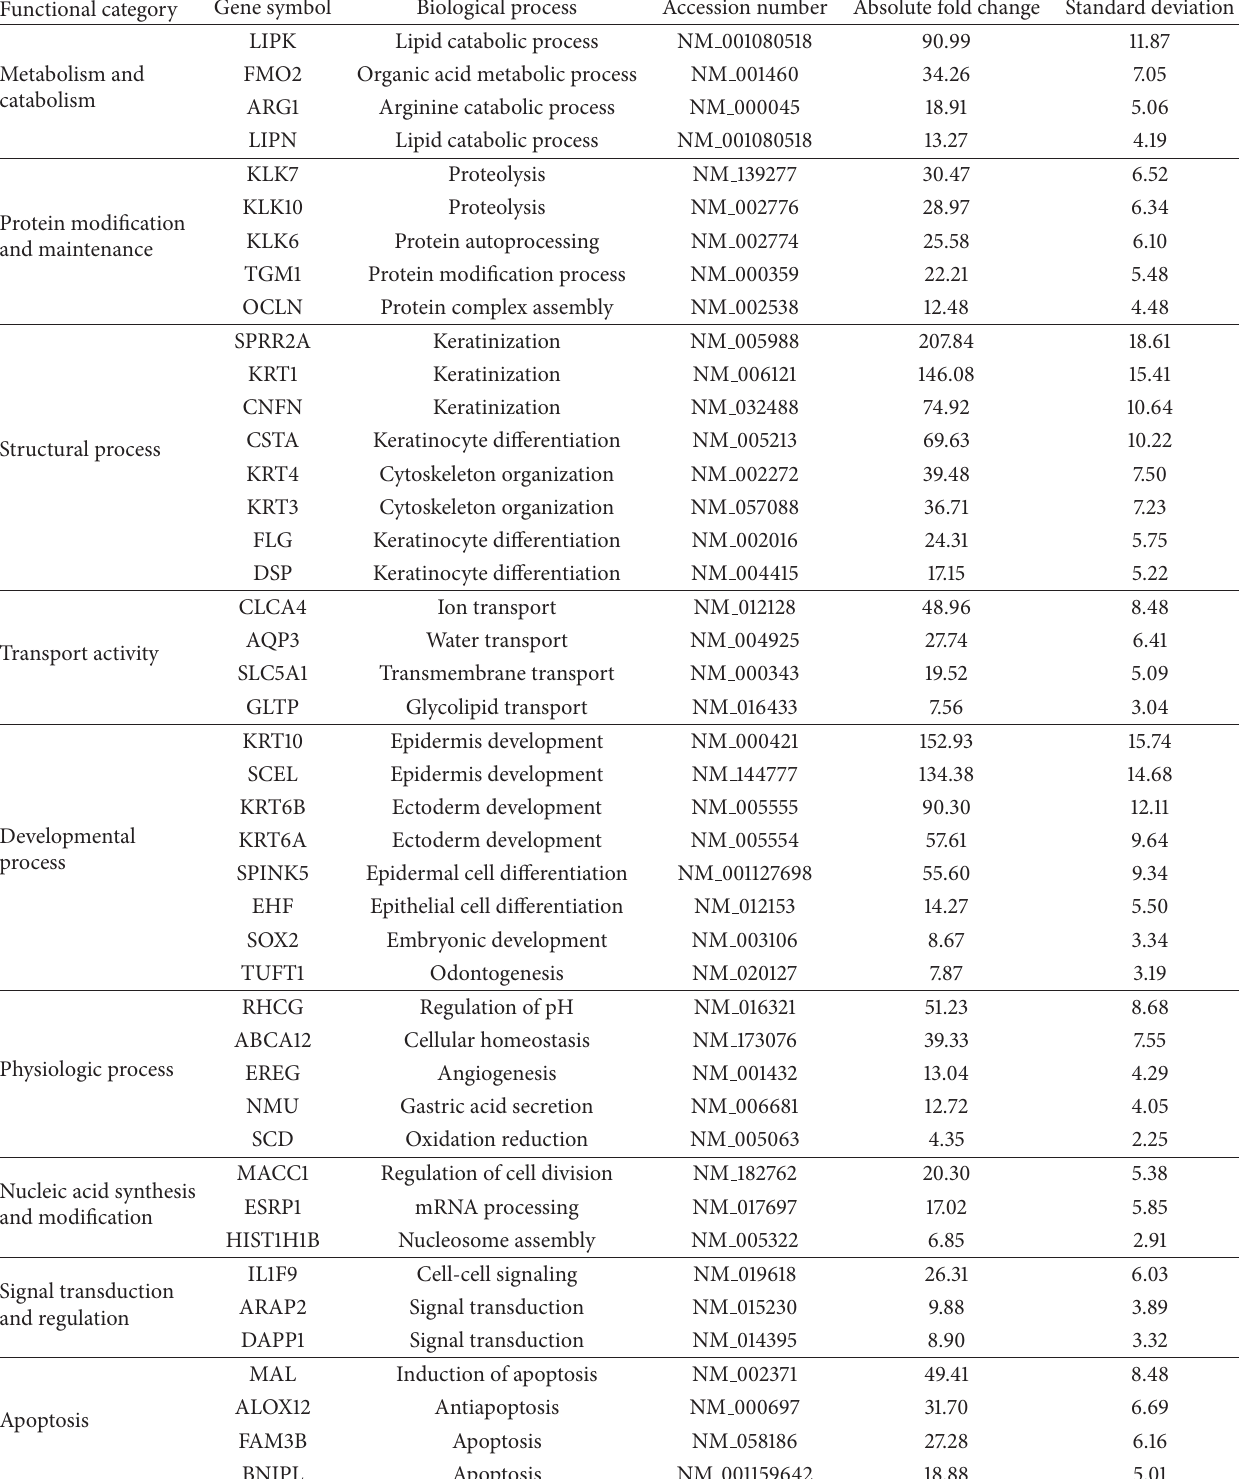
Table 2: Representative genes differentially expressed with higher expression levels in the gingiva than in dental follicles (absolute fold change >